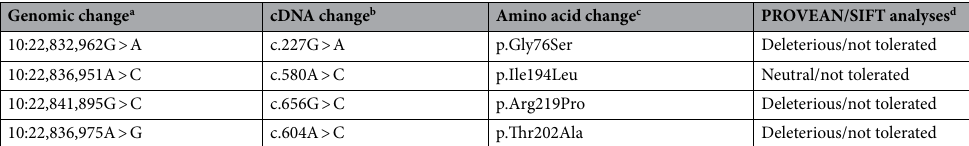
Table 1. Coordinates and functionality predictions for CYB5R3 missense variants in dogs with hereditary methemoglobinemia. a Numbered according to CanFam3.1 b Numbered according to NM_001048084. c Numbered according to NP_001041549. d Predictions of the effect of the amino acid substitution [SIFT 41 , PROVEAN (https ://prove an.jcvi.org)].